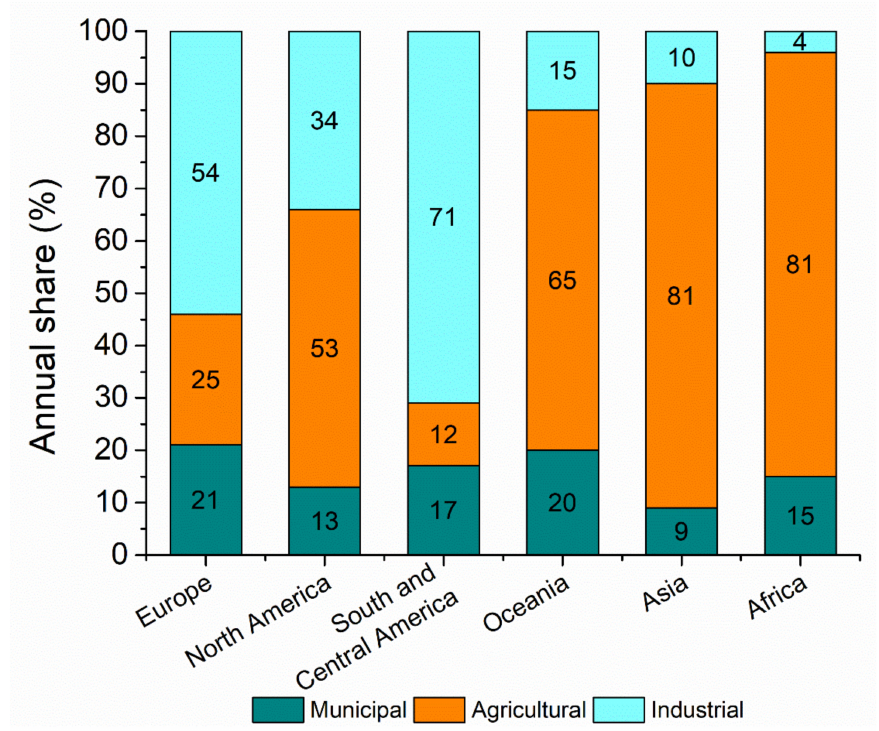
Figure 1. Annual share of global water uptake by activity and region [2], revised by